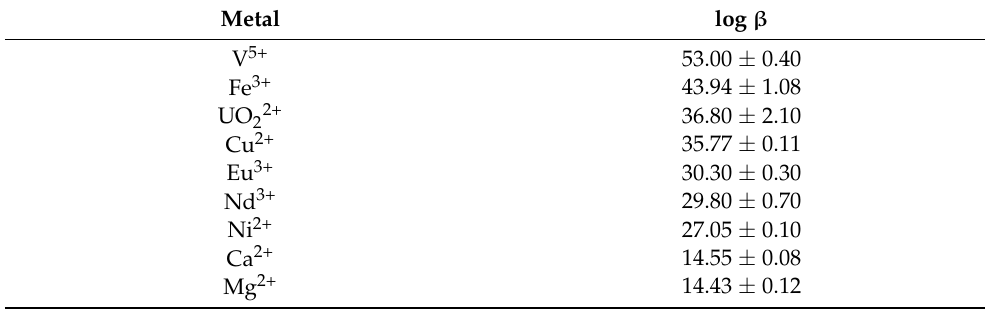
Table 4. Stability constants ( β , binding constants) of the glutarimidedioxime complexes with selected metal cations